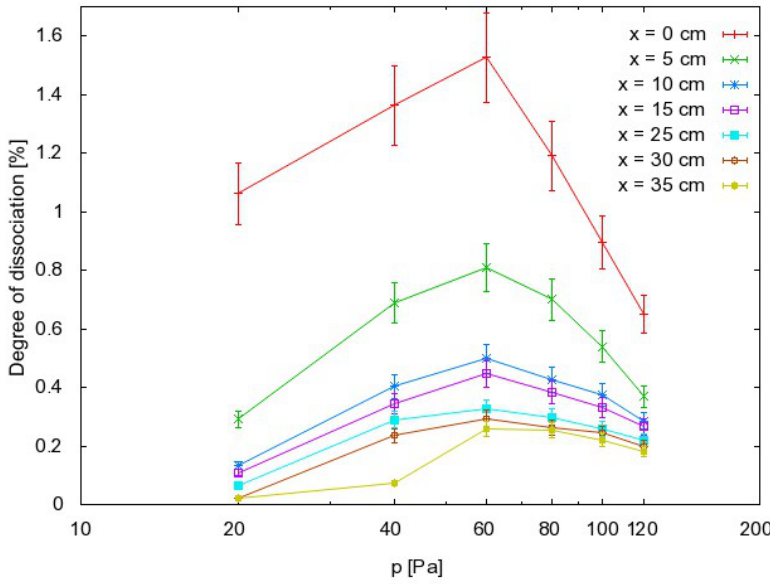
Figure 7. Dissociation fraction of CO pressure. Relative error is the same as in density results ( ≈ 10%), while error in 0 measurement is